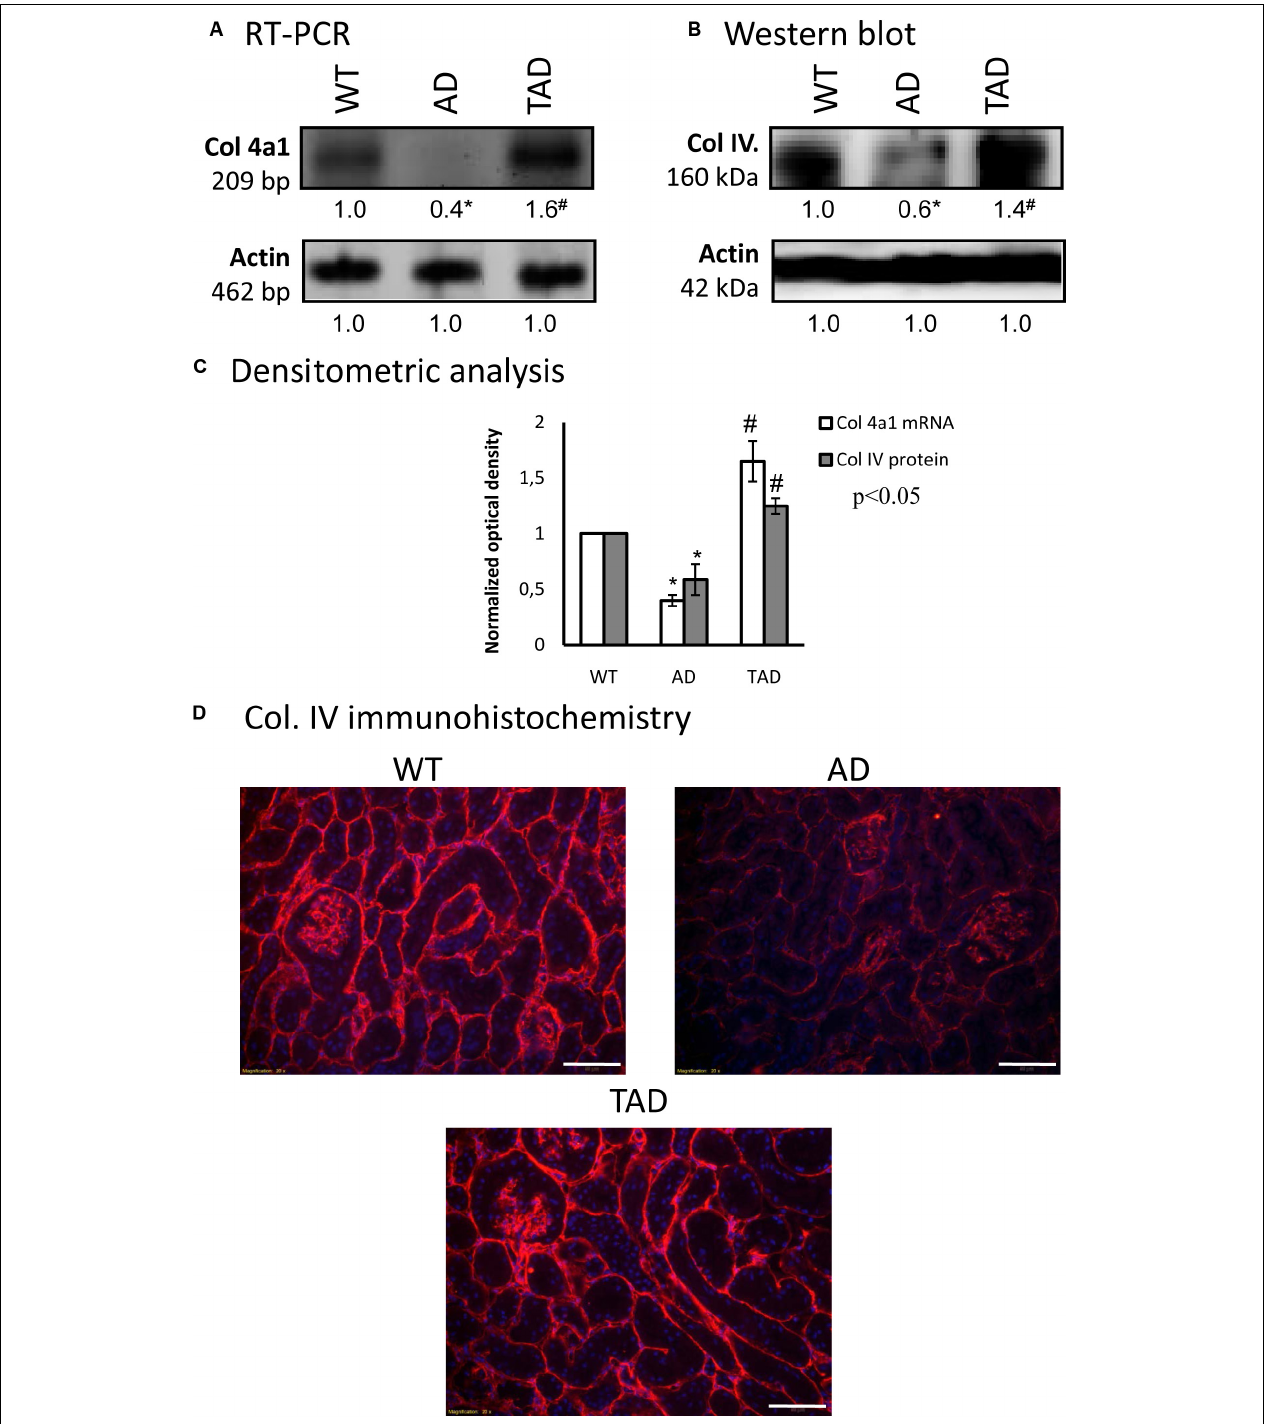
FIGURE 5 | mRNA (A) and protein (B) expressions of collagen type IV in the kidneys. For reverse transcription (RT-PCR) and for Western blot, actin was used as the control. The optical density of the signals was measured and the results were normalized to the optical density of the controls. For (A,B) , the numbers below the signals represent the integrated densities of the signals determined by ImageJ software. Asterisks indicate significant ( ∗ p < 0.05) alterations of expressions as compared to the wild type (WT) and ( # p < 0.05) compared to Alzheimer’s disease (AD). Representative data of five independent experiments. (C) Statistical analysis of the RT-PCR and Western blot data. All data presented are the averages of at least five different experiments. Statistical analysis was performed with Student’s t -test. All data were normalized on actin and are expressed as the mean ± SEM. (D) Immunohistochemistry of collagen type IV in the cortex of the kidneys. Magnification was made with × 20 objective. Scale bar , 50 µ